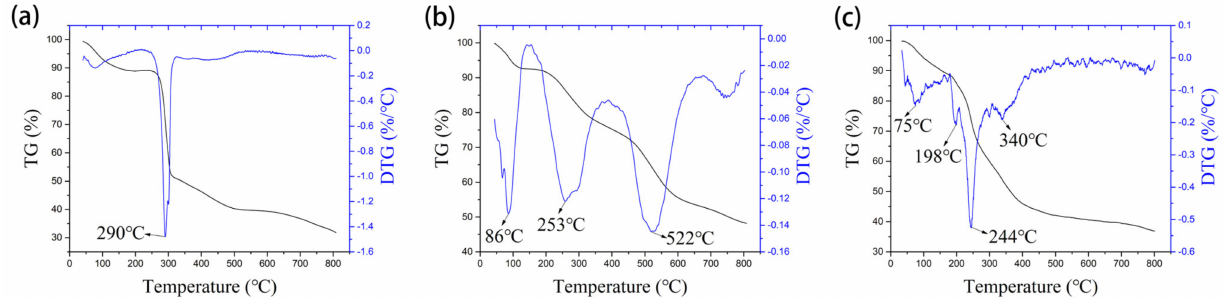
Figure 6. The TGA and DTG curves of CMC ( a ), PANI ( b ) and Cu II/I @CMC-PANI film ( c